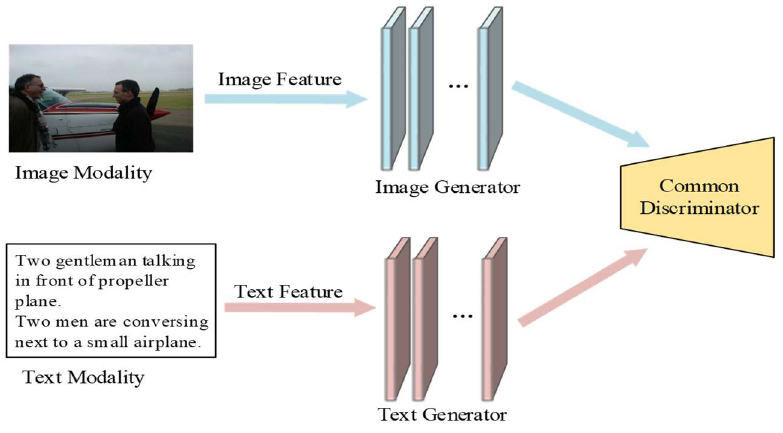
Figure 6. The adversarial learning network. It reduces the difference between the different modal feature distributions using the min−max mechanism.